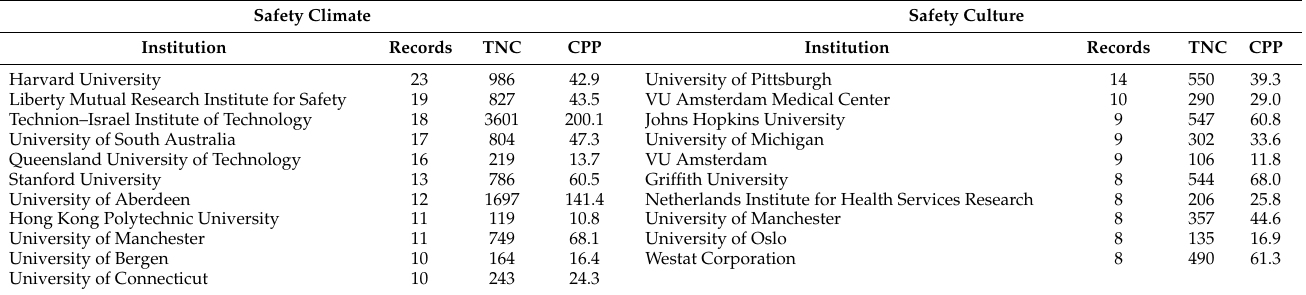
Table 3. Top 10 most productive institutions in safety climate and safety culture